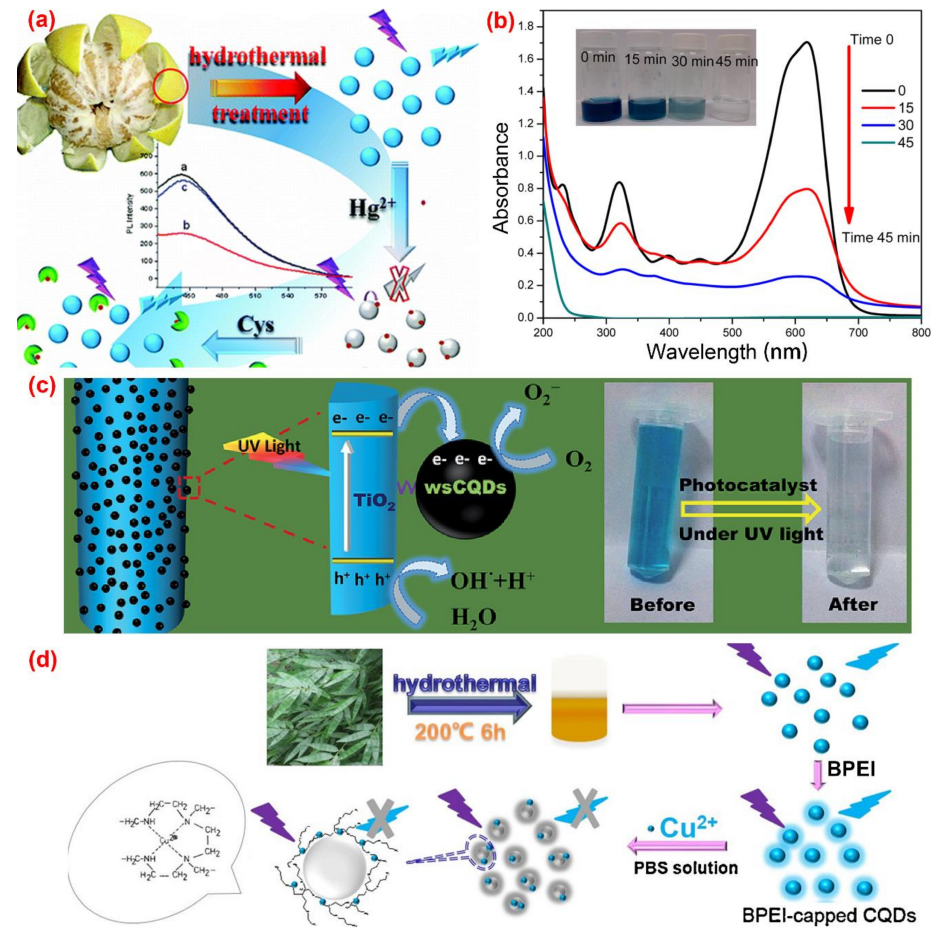
Figure4. ThepreparationoffluorescenceC-dotsfrombiomasswastesthroughthehydrothermalmethod. ( a ) The preparation and application of C-dots from pomelo peel [58]; ( b ) absorption spectra of naphthol blue-black (NBB) azo dye over C-dots / ZnO at di ff erent irradiation intervals [59]; ( c ) the photocatalytic degradation of methylene blue (MB) on TiO 2 –C-dots composite under UV light irradiation [60]; ( d ) the synthesis and application of C-dots from bamboo leaves